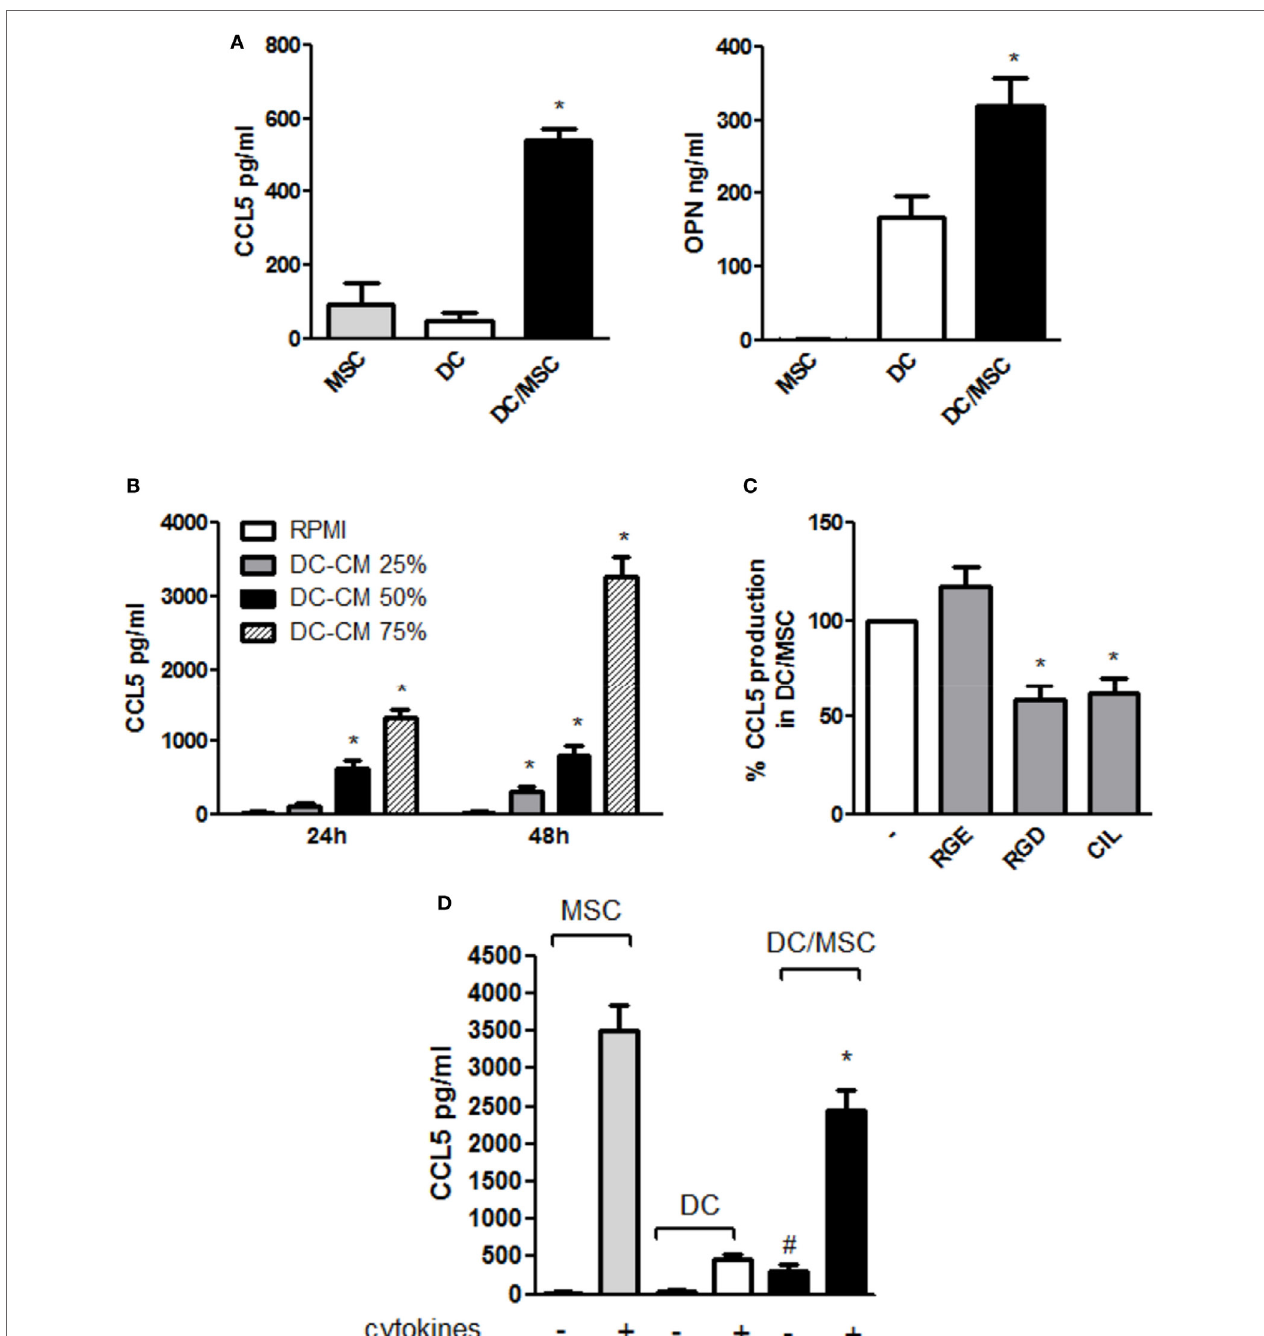
FigUre 5 | Osteopontin (OPN) released by dendritic cells (DCs) modulates CCL5 production in DC/mesenchymal stromal cells (MSC) coculture. (a) DCs were cultured in the absence or in the presence of MSCs. Supernatants were harvested after 48 h and assayed by ELISA for CCL5 (left) and OPN (right) (mean ± SEM of four independent experiments). * p < 0.05 vs. DC alone by one-way ANOVA followed by Tukey’s Multiple Comparison Test. (B) MSC were incubated for 24 and 48 h with different concentrations of DC conditioned medium (DC-CM) and CCL5 concentrations were measured in the supernatants by ELISA (mean ± SEM of four independent experiments). * p < 0.05 vs. MSC alone at 24 and 48 h, respectively by Student’s t -test. (c) DCs and MSCs were cocultured for 48 h in the presence or in the absence of the antagonistic integrin inhibitors RGD (10 µg/ml) and cilengitide (CIL) (2 µg/ml). RGE was used as a control peptide. CCL5 concentrations were tested by ELISA. Results are expressed as % of CCL5 production by DC/MSC set as 100% and are representative of four independent experiments. * p < 0.05 vs. DC/MSC coculture in presence of RGE by Student’s t -test. (D) DCs were cultured alone or with MSCs (ratio DC/MSC 5:1) in the absence or in the presence of the proinflammatory cytokines (IL-1 β , TNF- α , IL-6) for 48 h and OPN levels was determined in the supernatants by ELISA (mean ± SEM of seven different experiments). # p < 0.05 vs. DCs alone in the absence of cytokines; * p < 0.05 vs. MSCs alone in the presence of cytokines by Student’s t